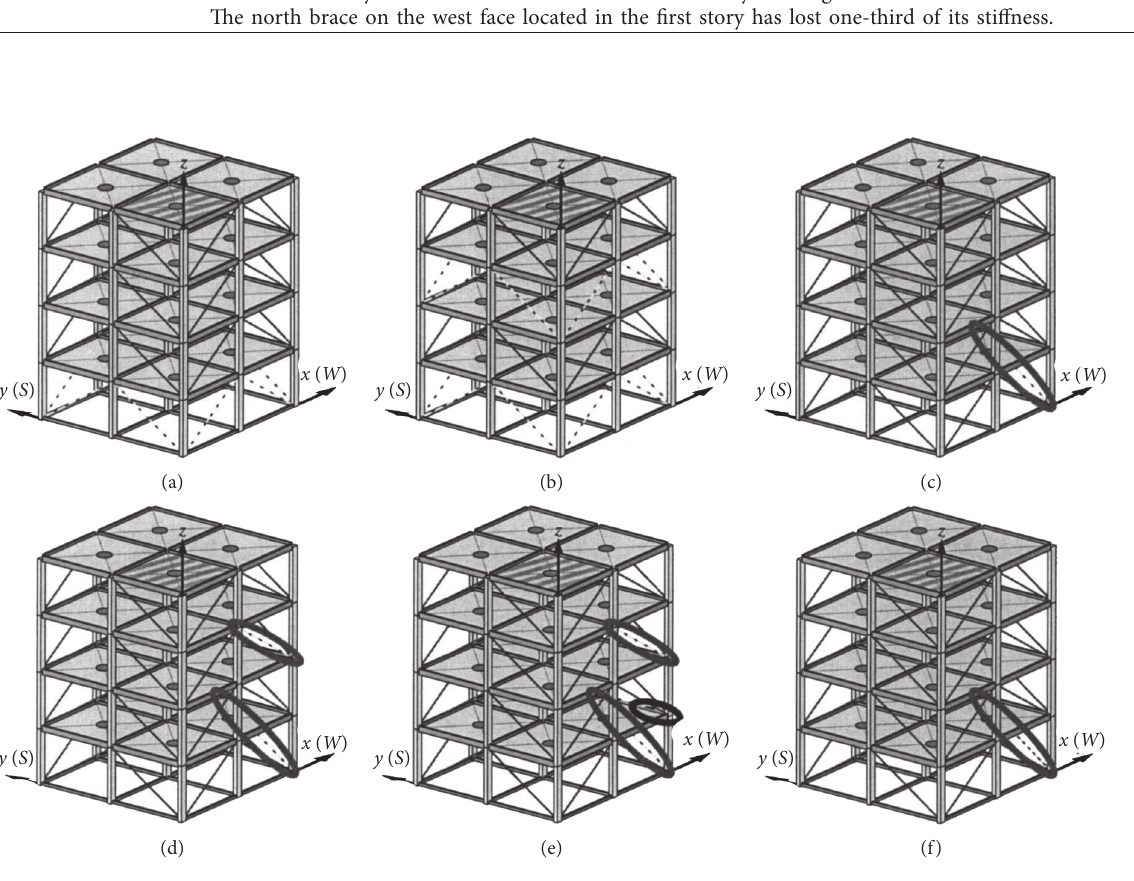
Figure 6: The six damage patterns considered for the IASC-ASCE benchmark structure [37]: (a) no stiffness in 1st floor braces, (b) no stiffness in 1st floor braces and no stiffness in 3rd floor braces, (c) no stiffness in one 1st floor brace, (d) no stiffness in one 1st floor brace and no stiffness in one 3rd floor brace, (e) no stiffness in one 1st floor brace and no stiffness in one 3rd floor brace beam-column connection weakened, and (f) 2/3 stiffness in one 1st floor brace.